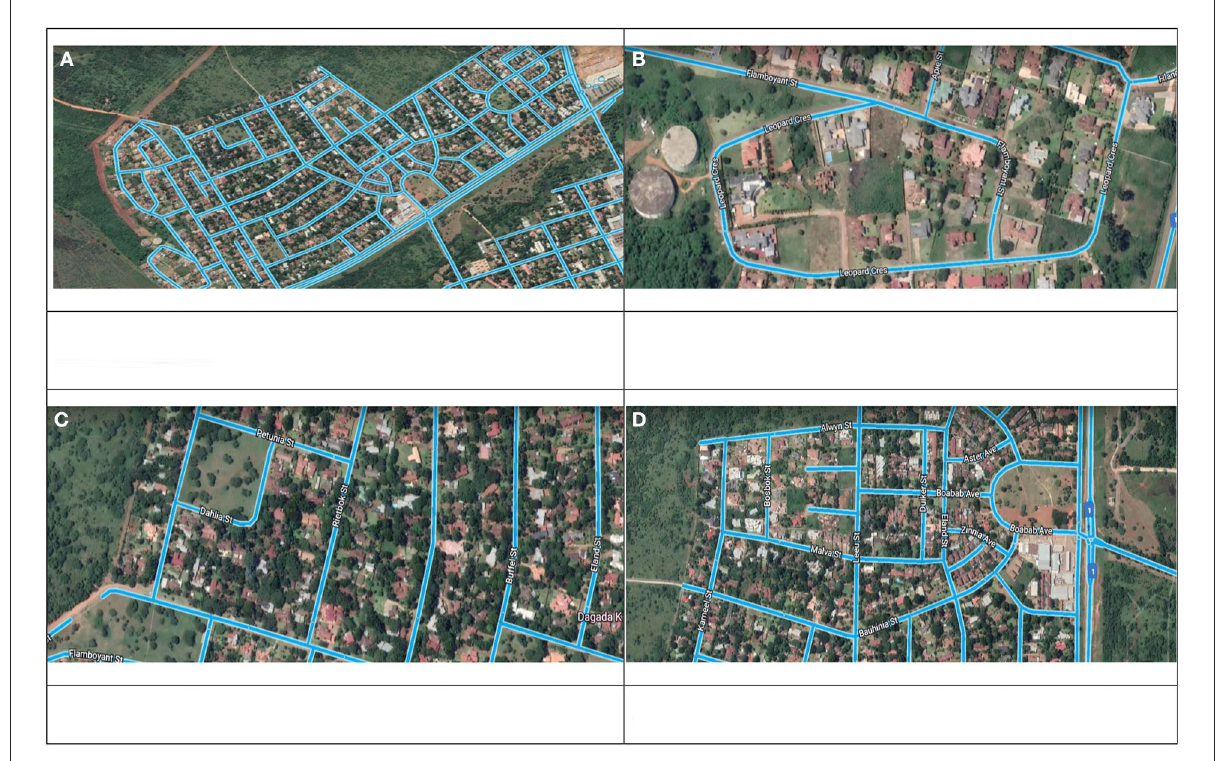
FIGURE5 2D streetscapes and blockscapes layout and arrangement in new town residential area, Louis Trichardt. (A) Streetscapes and blockscapes aerial 2D view of new town—the proximity of the neighborhood to N1 as well as the block layout and streetscape that encourages permeability, easy accessibility and exit, and ease legibility providing opportunities for quick escape by criminals, especially those that are mobile. (B) Streetscapes and blockscapes aerial 2D view of new town showing vacant/open stands that pose security threat in area. (C) 2D streetscape and layout showing big open space as well as stands bordering farms—which edge farmlands and forests are used by criminals as get-away and hiding nests. (D) 2D streetscape and blockscape showing cul-de-sac and short avenues that enhance neighborhood surveillance and community or street/block